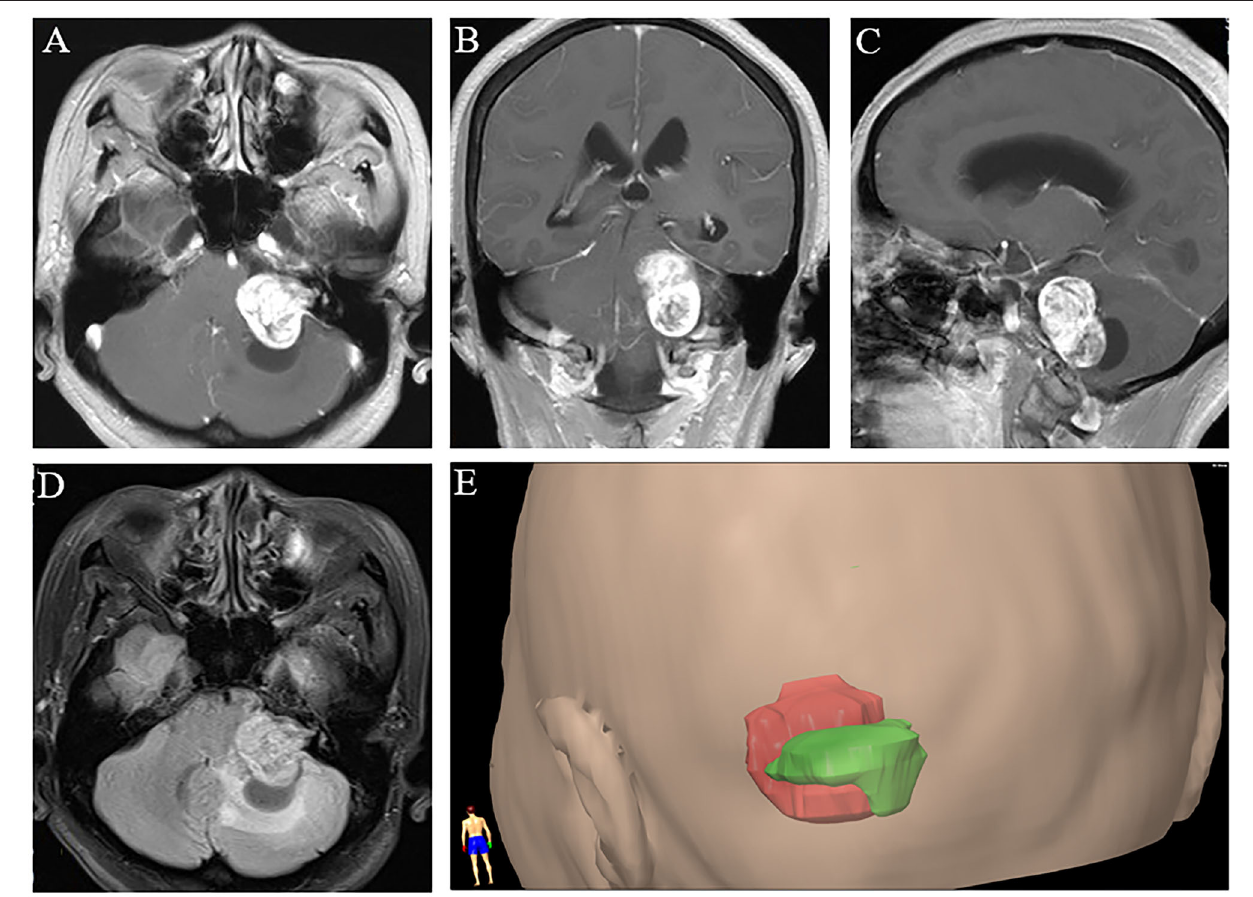
FIGURE 1 | Three-dimensional magnetic resonance imaging reconstruction of vestibular schwannoma with peritumoral brain edema. (A–C) Post-contrast axial, coronal, and sagittal T1-weighted images. (D) T2-weighted fluid-attenuated inversion-recovery image. (E) A representative image of three-dimensional reconstruction with tumor in red and peritumoral edema in